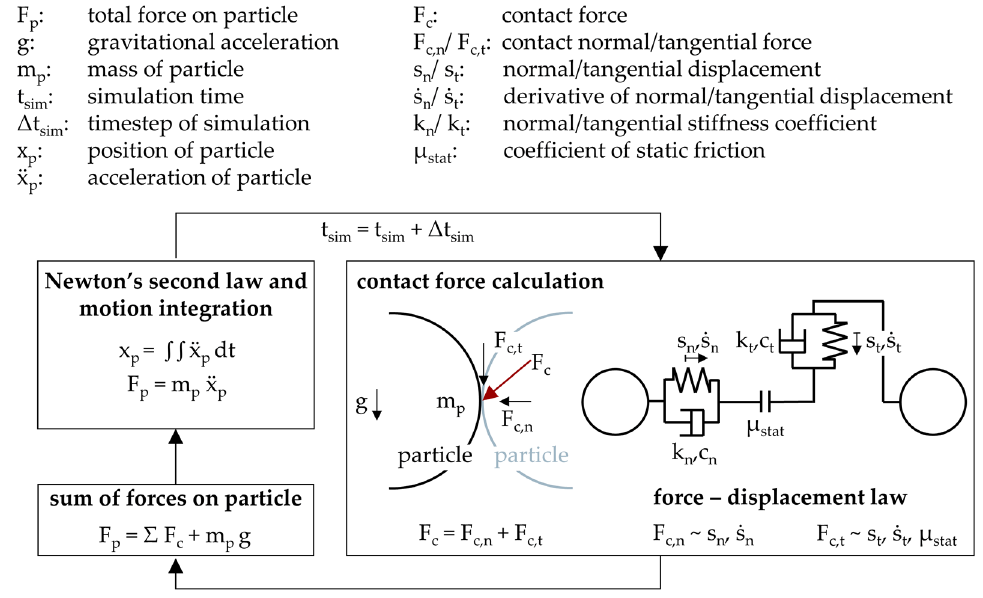
Figure 1. DEM calculation